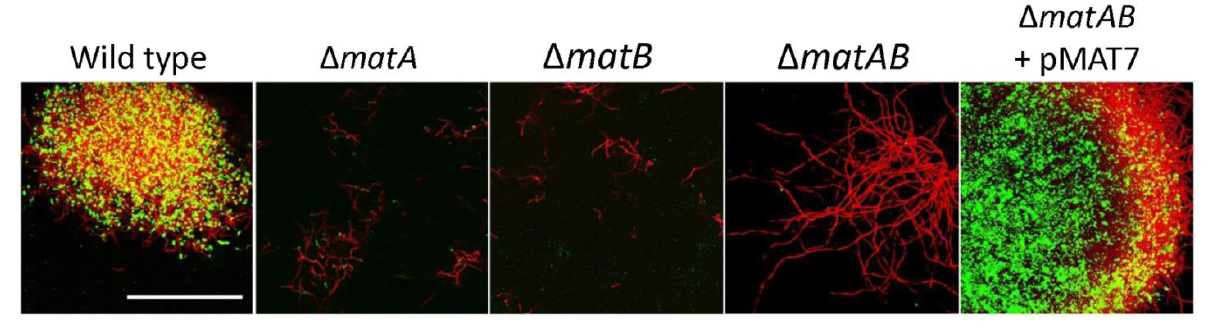
FIGURE 4: PNAG biosynthesis depends on MatA and MatB. Mycelia from 18 h liquid-grown cultures were stained with mAb F598 (green), showing PNAG-specific staining for the wild-type strain S. lividans 66, while it was absent in mutants lacking matA , matB or the matAB dou- ble mutant. Genetic complementation via introduction of pMAT7 expressing matA and matB restored PNAG formation to the matAB double mutant. To visualize the hyphae, the DNA was stained with PI (red). Colocalization of PI and mAb F598 is shown in yellow. Bar: 50